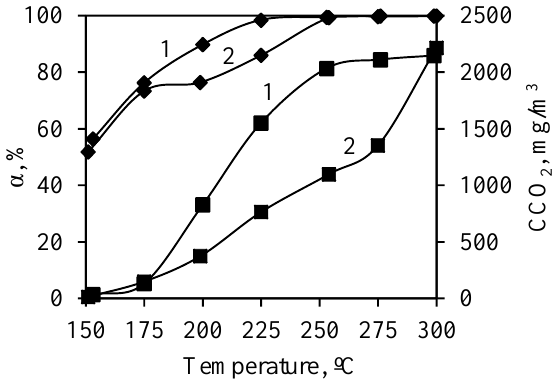
Figure 8. Degree of conversion ( ♦ ) and accumulated CO 2 concentration ( ■ ) during catalytic oxidation of propanol in synthetic (1) and calcined (2) samples.